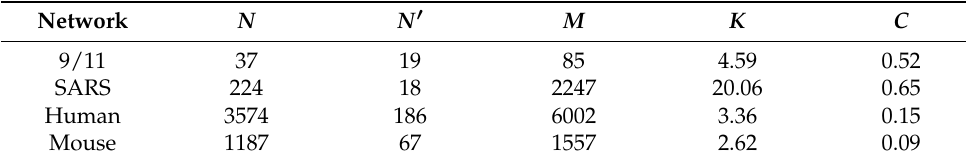
Table 1. Network topology